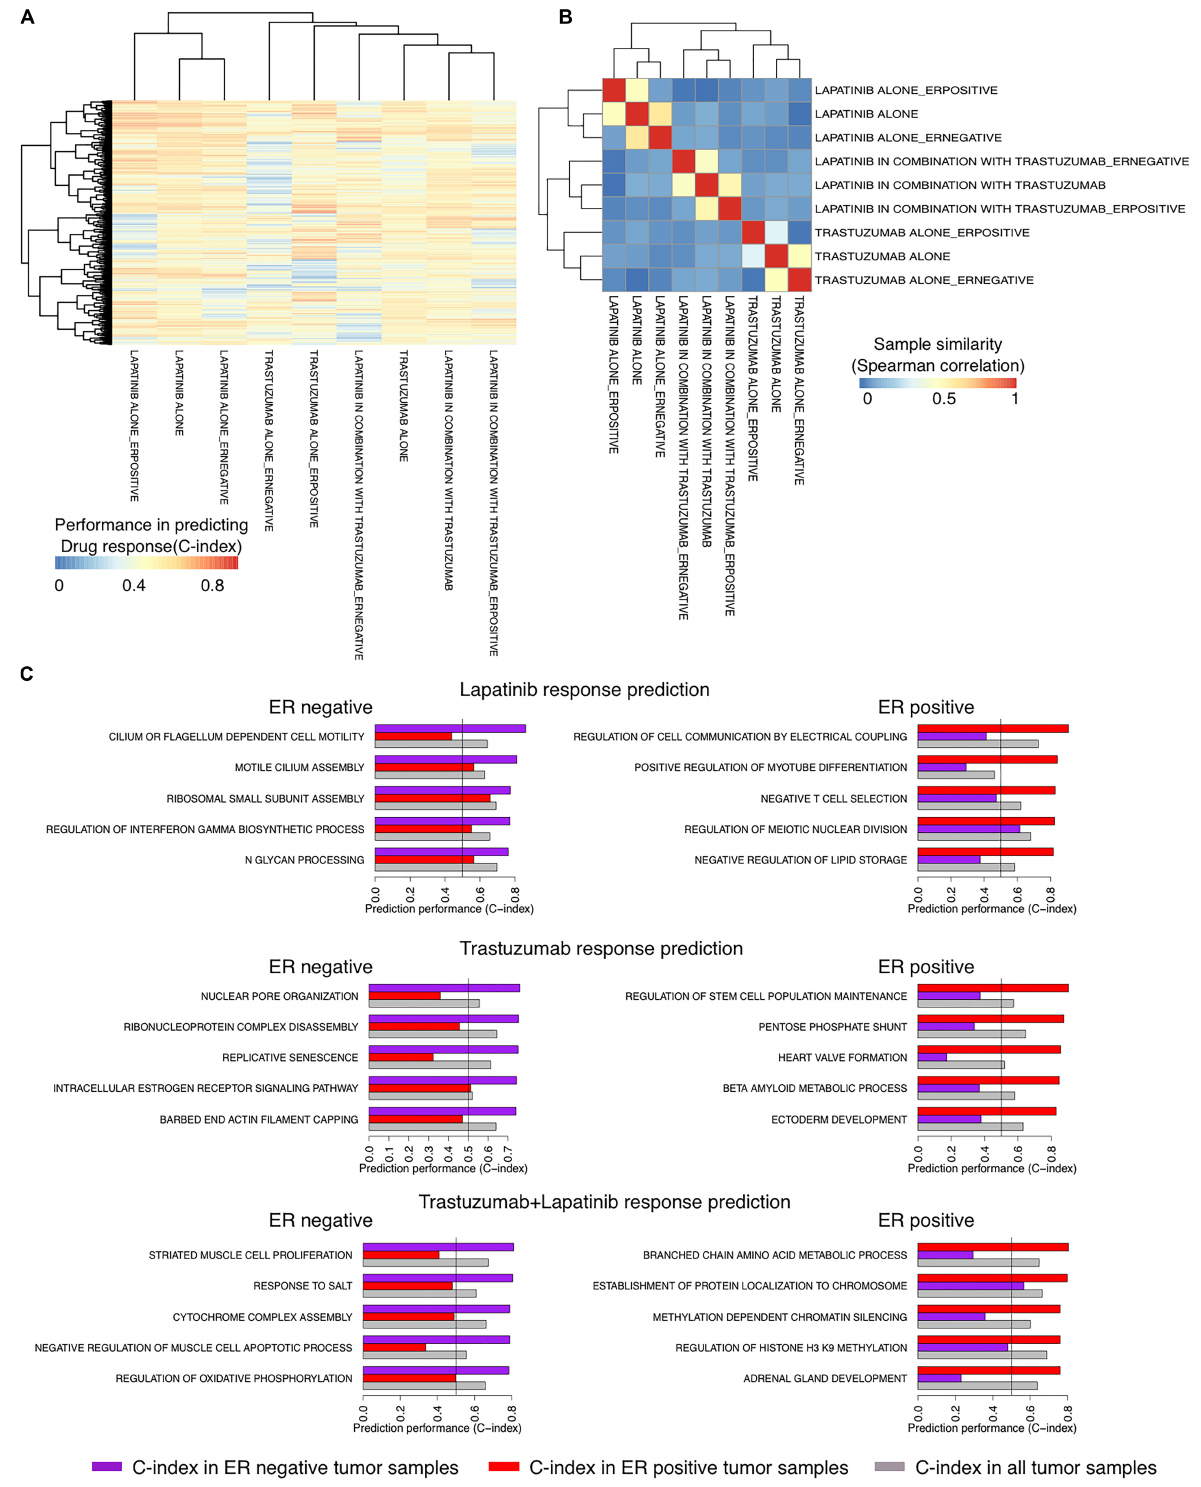
Frontiers in Genetics |